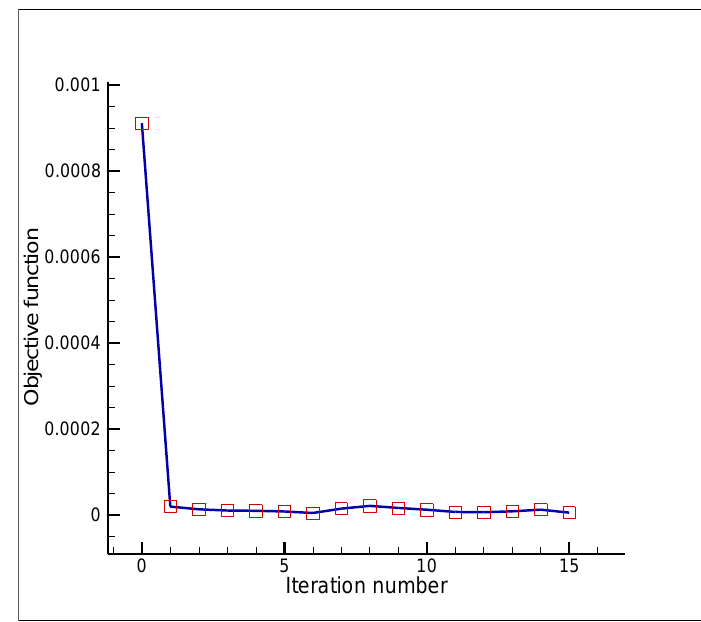
Figure 11. History of the objective function, J = ( D